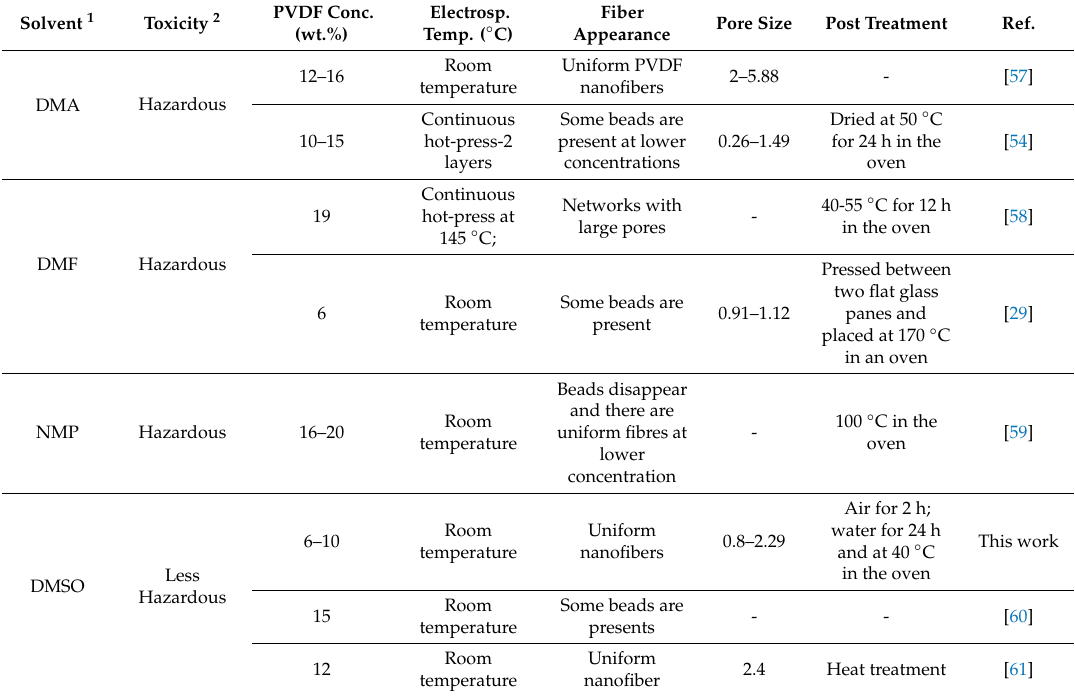
Table 5. Most relevant works of PVDF ENMs membranes with di ff erent